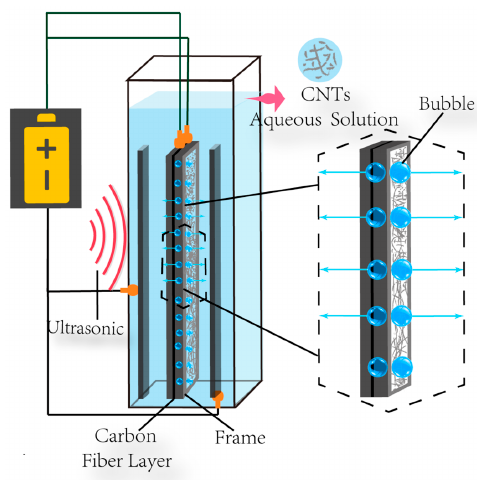
Figure 1. Schematic for ultrasonically assisted electrophoretic deposition (EPD) process of carbon nanotubes (CNTs) onto carbon fiber.